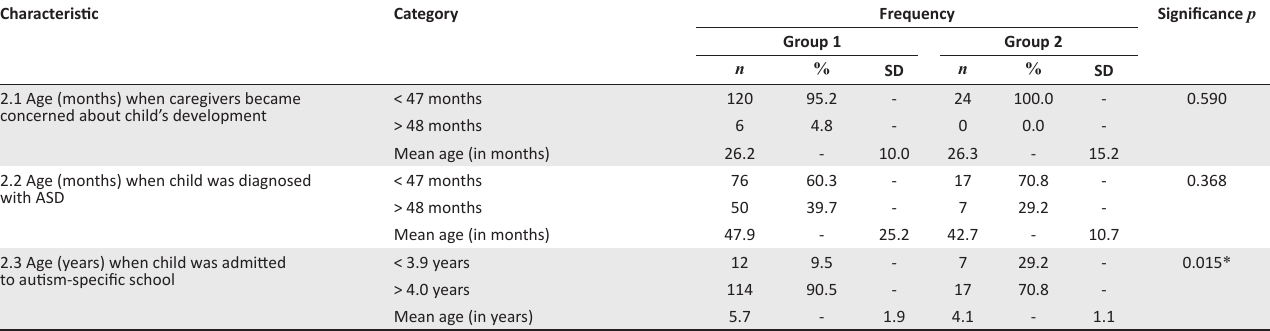
TABLE 2: Profiles of learners in group 1 ( n = 126) and group 2 ( n = 24).